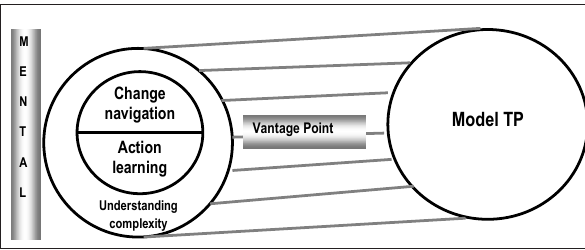
FIGURE 4: The vantage point of change navigation and action learning, leveraged from the appropriate complexity